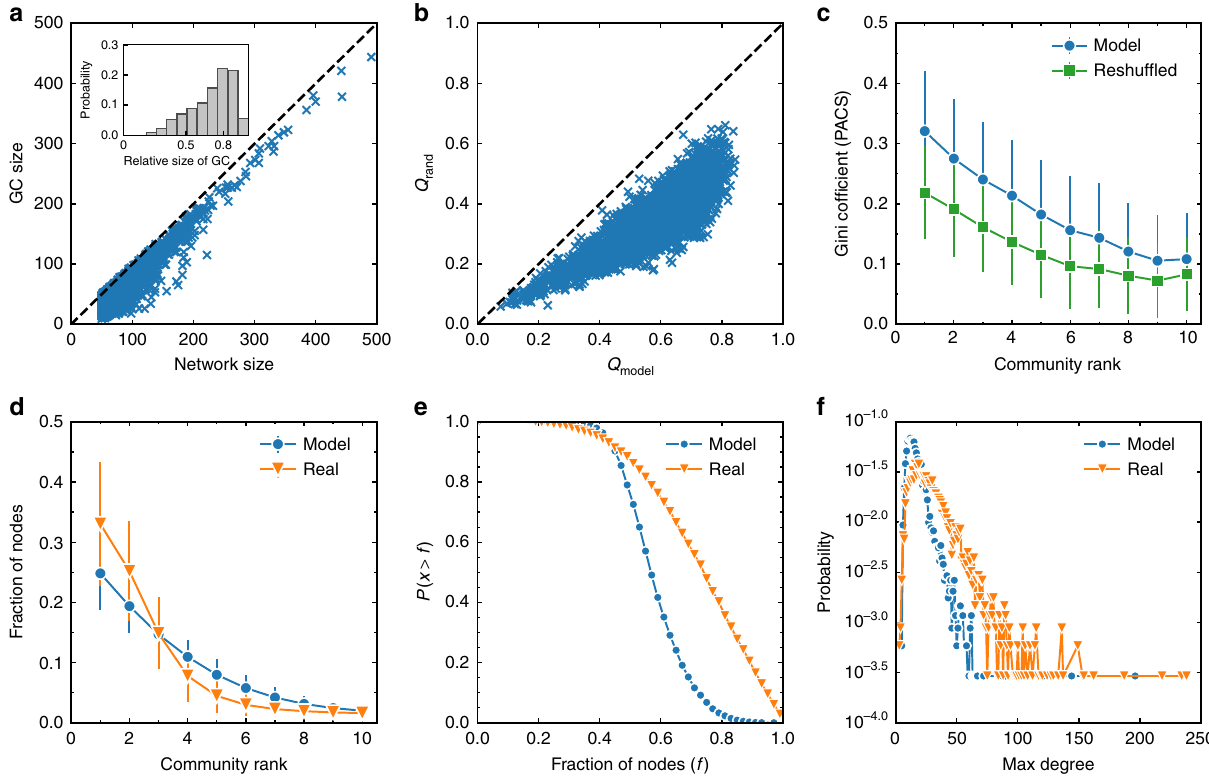
Fig. 6 Structural properties of the generated scientists ’ CCNs based on the EEM. a The size of the modeled co-citing network (CCN) versus the size of CCN ’ s giant component (GC). Each point represents a modeled scientist. b The maximized modularity in the modeled CCNs ( Q model ) and the maximized modularity in their degree-preserved reshuf fl ed counterparts ( Q rand ). c The Gini coef fi cient of the distribution of PACS codes in different communities. Communities are ranked by size in a descending order. The model data are compared with a random counterpart, where the PACS codes are reshuf fl ed. d The fraction of papers in different communities of real data and model data. e The inverse cumulative probability of fraction of nodes in the three largest communities for real data and model data. f The distribution of the maximum degree in scientists ’ real CCNs and modeled CCNs. In this fi gure, the parameters of EEM are chosen as p = 0.6 and q = 0.2, and the error bars represent standard